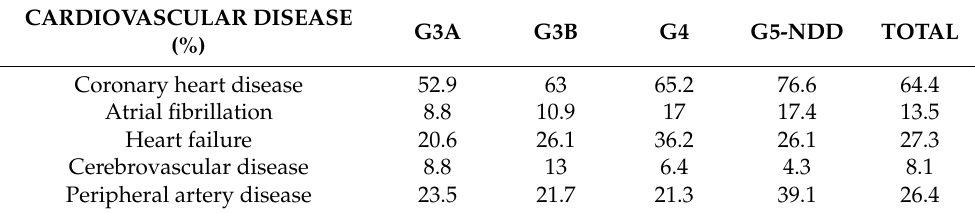
Table 3. Prevalence of cardiovascular disease, global and by